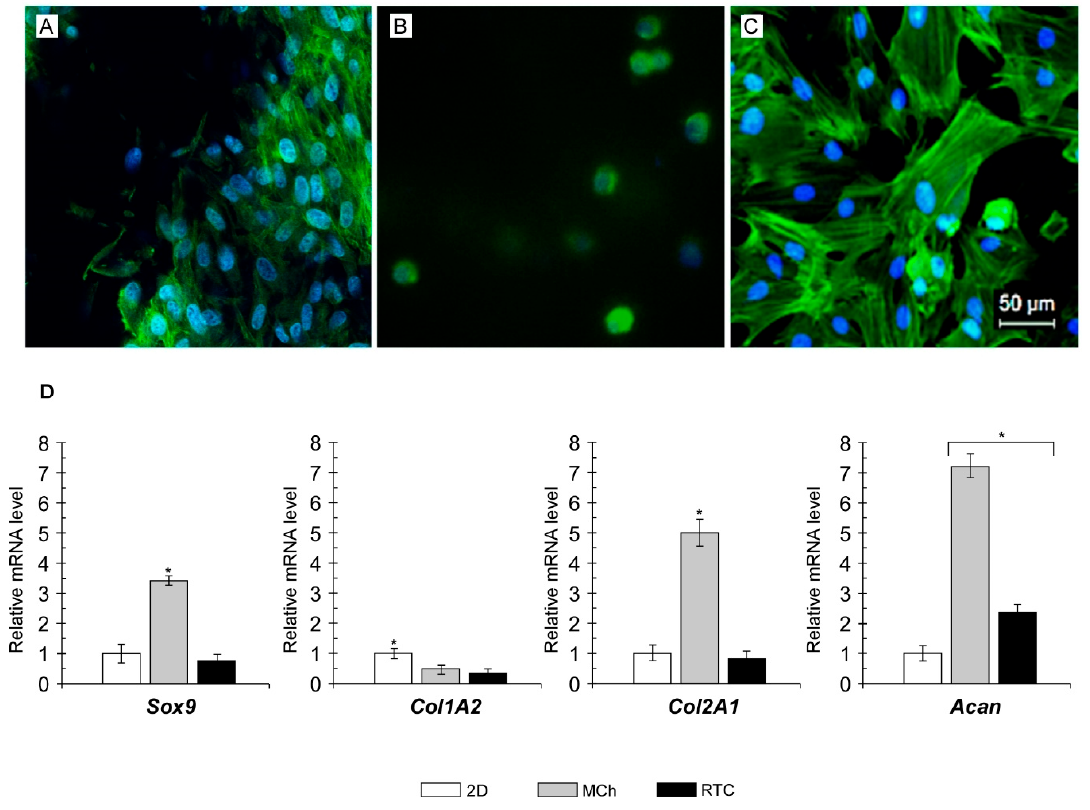
Figure 7. Culturing in MCh does not alter cytoskeleton organization and NCs express markers of the differentiated state. Staining of NCs after 8 days of culture, respectively, within RTCh ( A ), MCh ( B ) and 2D ( C ). It is possible to observe the characteristic cytoskeletal localization of F-actin in NCs grown under 2D conditions ( C ); a more widespread distribution has been observed in RTCh ( A ). The localization of F-actin is almost not observed in NCs grown in MCh ( B ), which maintains the morphology round over time. The F-actin cytoskeleton was stained with Phalloidin FITC (green); the nuclei were stained with DAPI (blue). Magnification was 10×; scale bar was 50 μ m. ( D ) Gene expression analyses of Sox9 , Col2A1 , Col1A2 and Acan by qRT-PCR. The gene expression levels were analyzed using the − ΔΔ Ct method using 18S rRNA and GAPDH as the internal controls. The data represent the mean ± SD of three independent culture experiments. Statistical analysis by one-way ANOVA. The symbol * indicates p < 0.05.